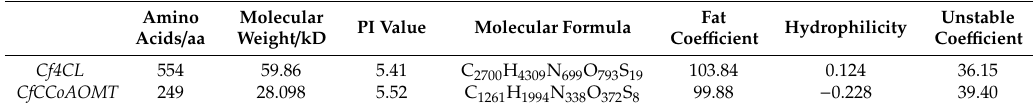
Table 2. Analysis of protein physical and chemical properties.